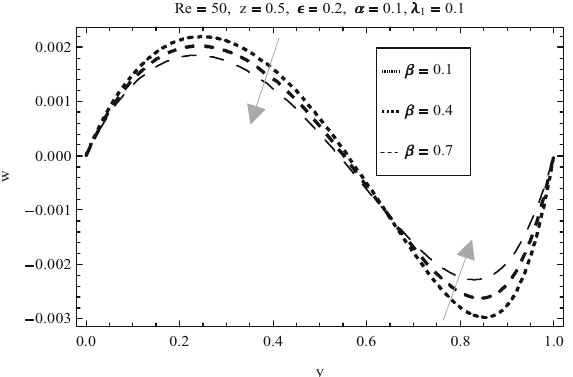
Fig. 11 Velocity component w along y for different values of β